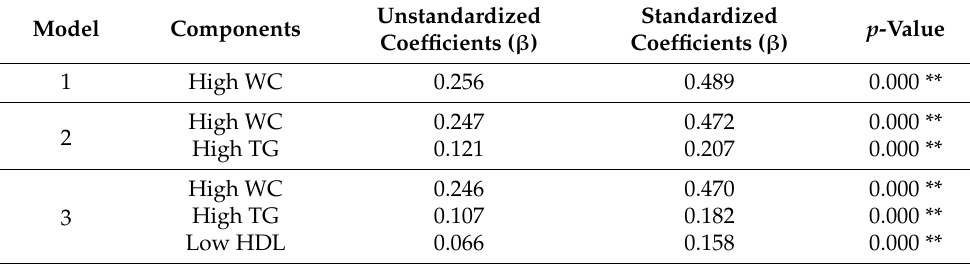
Table 4. Association between metabolic syndrome and its